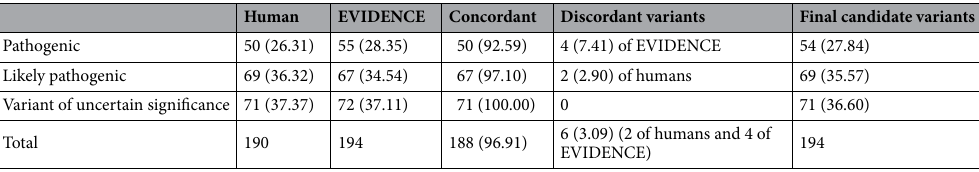
Table 2. The ACMG 2015 classifications of prioritized variants (n [%]).